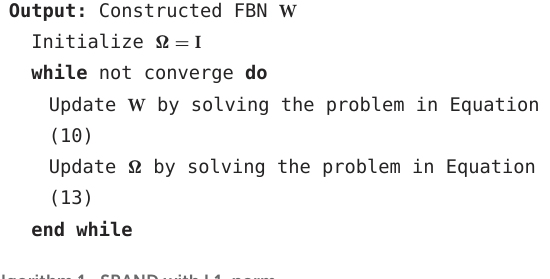
Algorithm 1. SRAND with